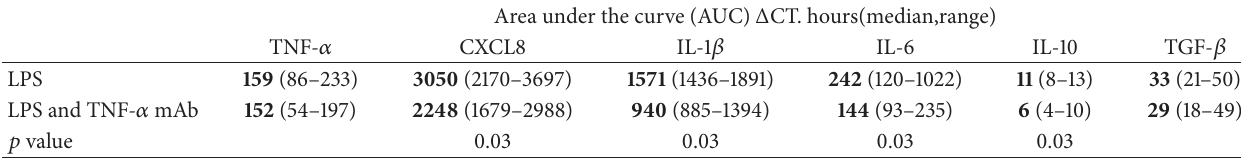
Table 2: Effect of TNF- 𝛼 mAb on pro- and anti-inflammatory cytokine mRNA expression in LPS-stimulated